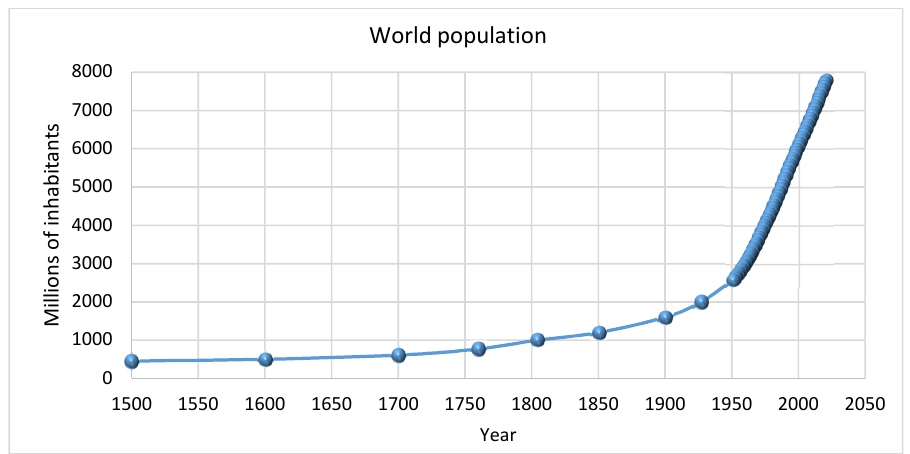
Figure 1. Development of the world population over recent centuries. Plot based on the data from Worldometer’s “World Population by Year” [2].